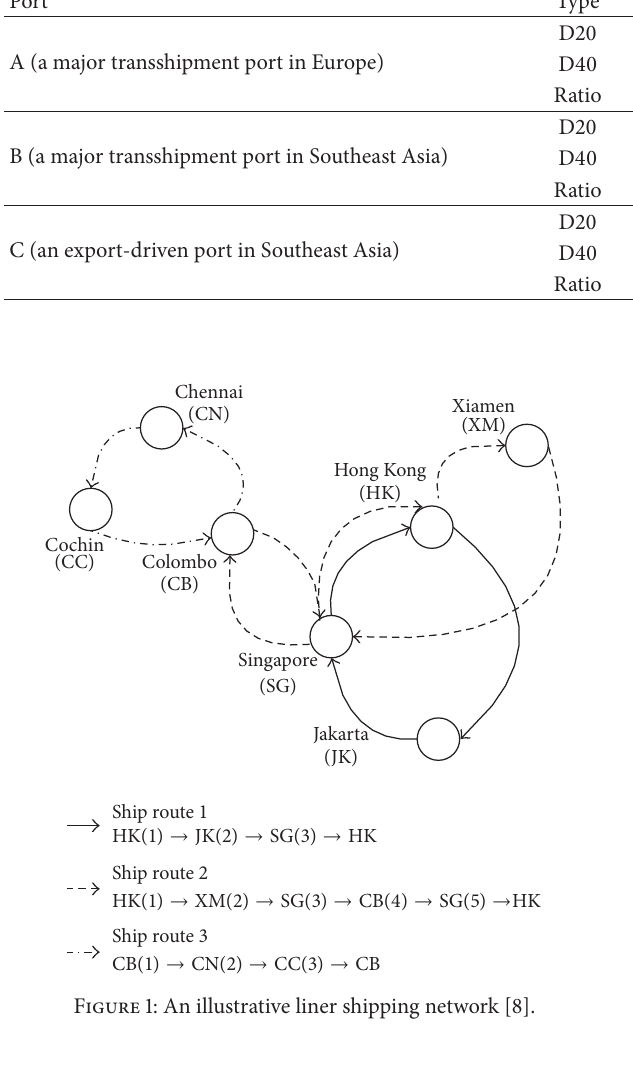
Table 1: Laden container handling cost (USD/container) at three ports (source: [11]). Port Type Loading Discharge